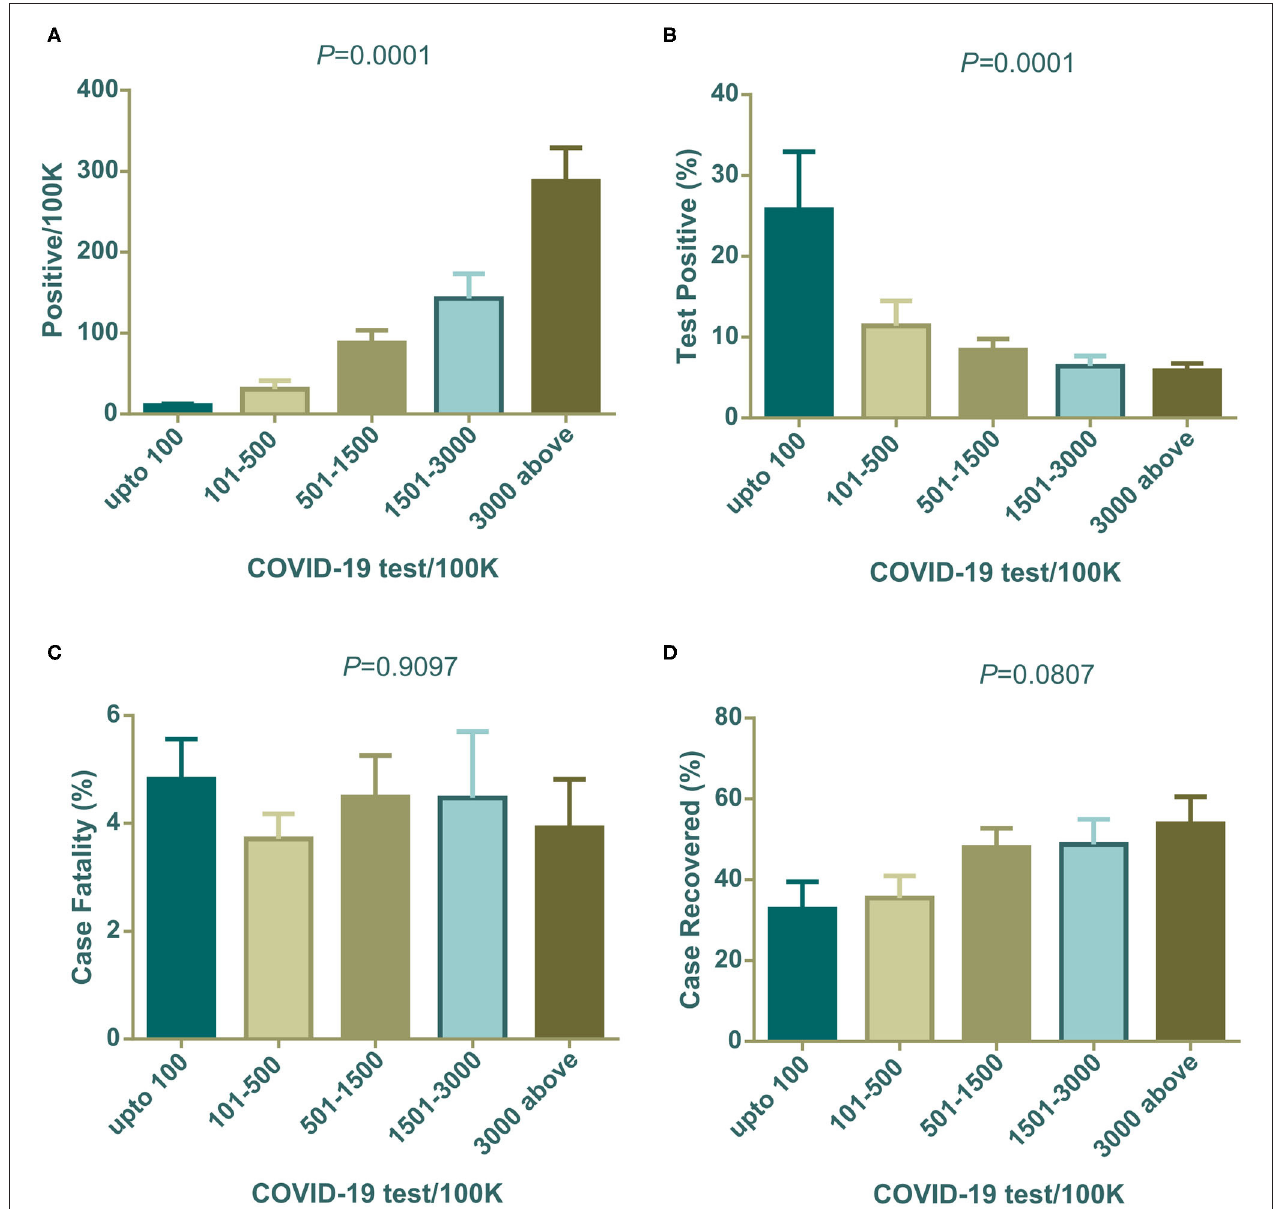
FIGURE 3 | Positives/100K, positive test (%), case fatality (%), and case recovery (%) data distribution among countries grouped with COVID-19 test/100K population. All are mean ± SEM. In one-way ANOVA variance among column means are statistically significant for (A,B) . Case fatality (%) and case recovered (%) were not statistically significant (C,D) . One way ANOVA differences among column means are shown as P-values on top of each graph.